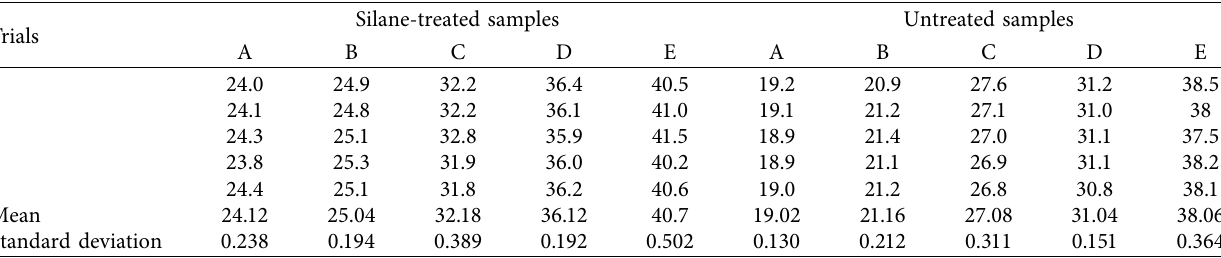
Table 3: Tensile test results of an epoxy